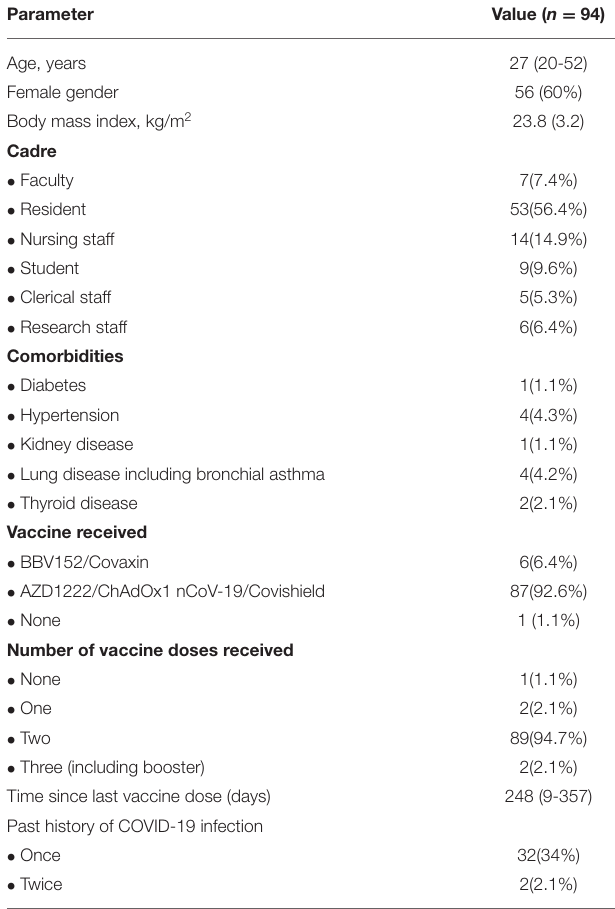
TABLE 1 | Baseline demographic and clinical parameters of the included